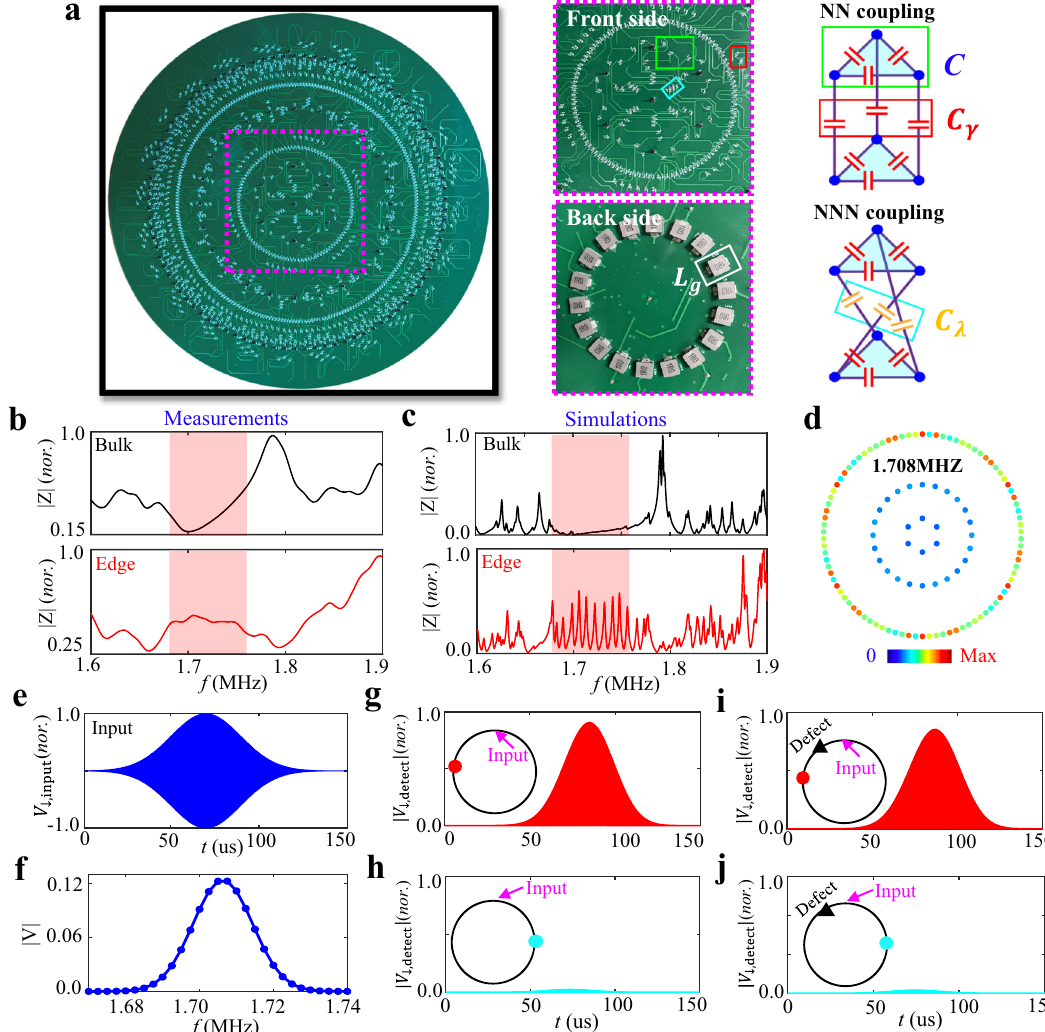
Fig. 2 Observation of boundary-dominated topological states in the hyperbolic Chern circuit. a The photograph image of the fabricated hyperbolic circuit. The part of enlarged views and the equivalent schematic diagram are presented in right insets. Three circuit nodes connected by the capacitor C are considered to form an effective lattice site, as enclosed by the green block. The real-valued NN hopping rate is achieved by directly linking adjacent nodes without a cross with three capacitors C γ (framed by the red frame). For the realization of NNN hopping rate with a direction-dependent phase, three pairs of adjacent nodes are connected crossly via three capacitors C λ enclosed by the blue block. Each node is grounded by an inductor L g framed by the white block in the back side. b , c Measured and simulated impedance responses of bulk (black lines) and edge (red lines) nodes. The red region corresponds to the energy range with nontrivial edge states. d The measured impedance distributions at 1.708 MHz. e , f The voltage packet and the associated frequency spectrum of the injected voltage packet. g , h The measured time tracks of the voltage pseudospin at nodes in the defect-free circuit along the counterclockwise and clockwise directions with respect to the excitation node. i , j The measured time tracks of the voltage pseudospin at nodes in the circuit with a defect along the counterclockwise and clockwise directions with respect to the excitation node. Red and blue dots in insets mark the position of two detection nodes and the pink arrow presents the input node. The black triangle corresponds to the defect. The circuit parameters used in experiments are set as C = 1 nF, C γ = 1 nF, C λ = 0.2 nF, L g = 1 uH and C P = 5